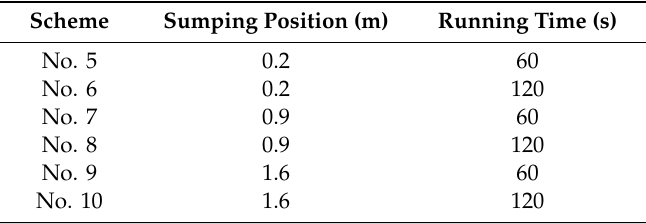
Table 3. Test scheme design of the shearer feeding